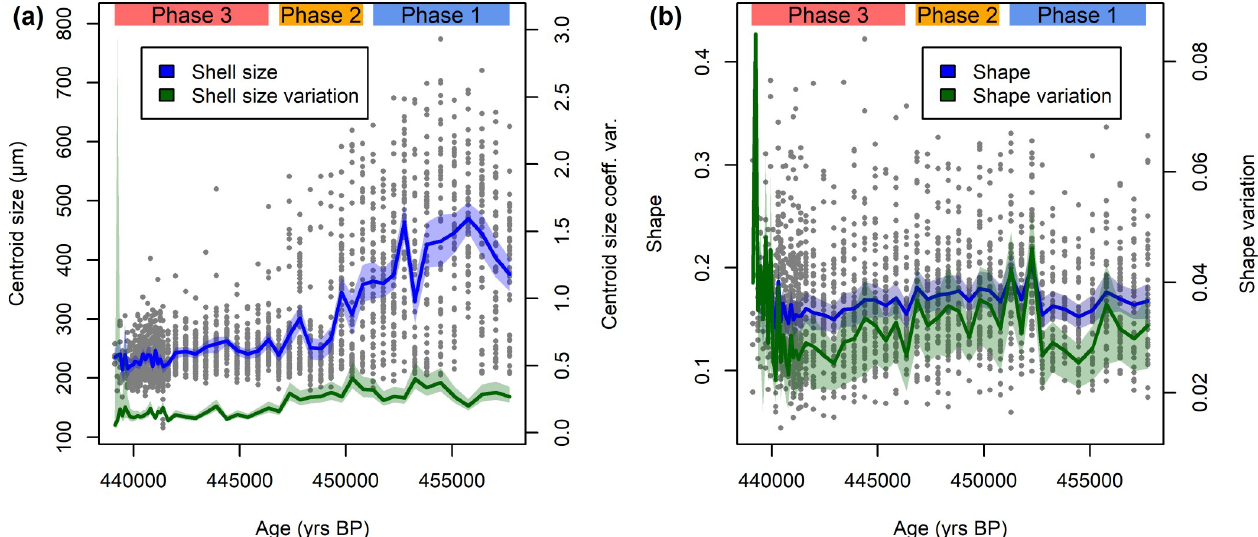
Fig 3. Morphology of Trilobatus sacculifer from marine isotope stage 12 in the Red Sea. The three phases defined by abundance (compare Fig 1) are indicated. (a) Shell size and its variation decrease toward the local extinction (compare S1 File). Raw values (grey dots) are plotted alongside the sample mean and coefficient of variation (solid lines) and their 95% confidence intervals (shaded area). (b) Shell shape (Riemannian shape distance from the mean shape) excluding sacculifer-morphotypes (compare S1 File). Raw values (grey dots) are plotted alongside the sample mean and standard deviation (solid lines) including the 95% confidence interval (shaded